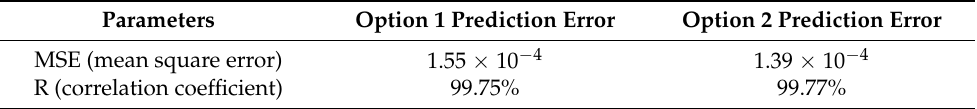
Table 3. Prediction